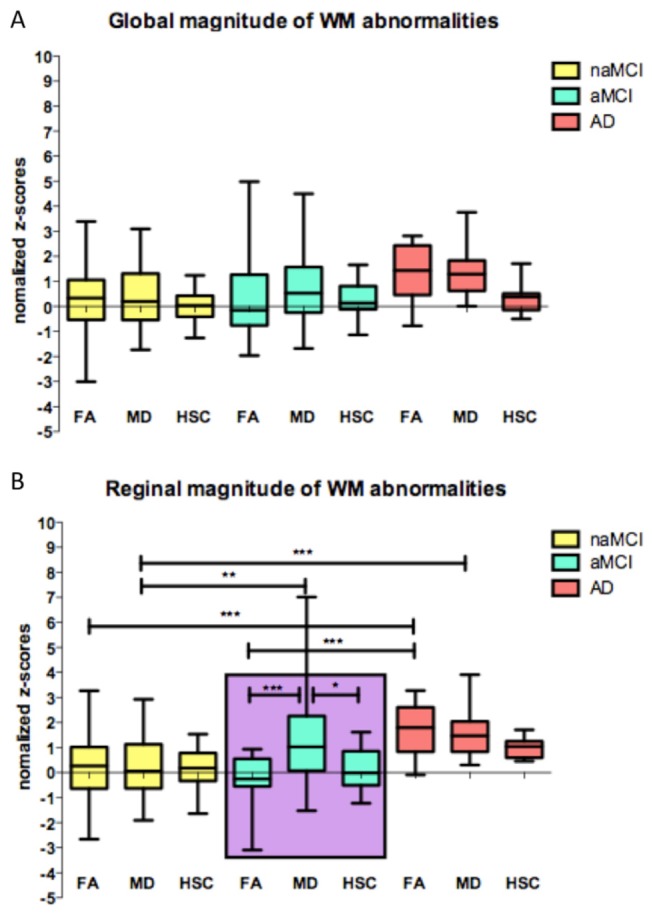
Global and regional magnitude of WM abnormalities in patient population.A shows that magnitude of global MD, FA and HSC abnormalities does not differ among patient groups (One way ANOVA (p=0.0018; F=3.212; df=8). In contrast, regional MD abnormalities predominates in aMCI (purple box) while FA abnormalities arises in AD (Figure 2B -- one way ANOVA (p<0.0001; F=7.74; df=8).Student-Newman-Keuls Post-hoc test ***, p=0.001; **,p=0.01.